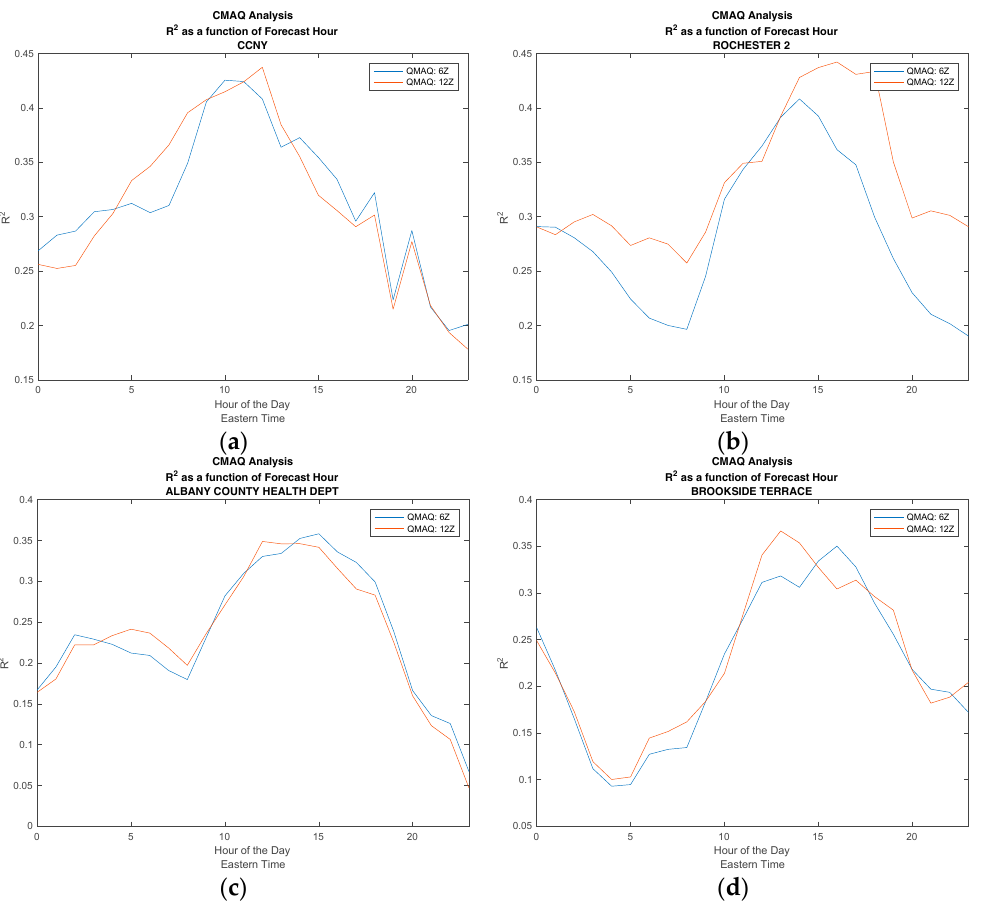
Figure 2. Comparing the effect of different release times for CMAQ by plotting the R 2 value as a function of time of day. ( a ) City College of New York (CCNY); ( b ) Rochester; ( c ) Albany; ( d ) Brookside Terrace.